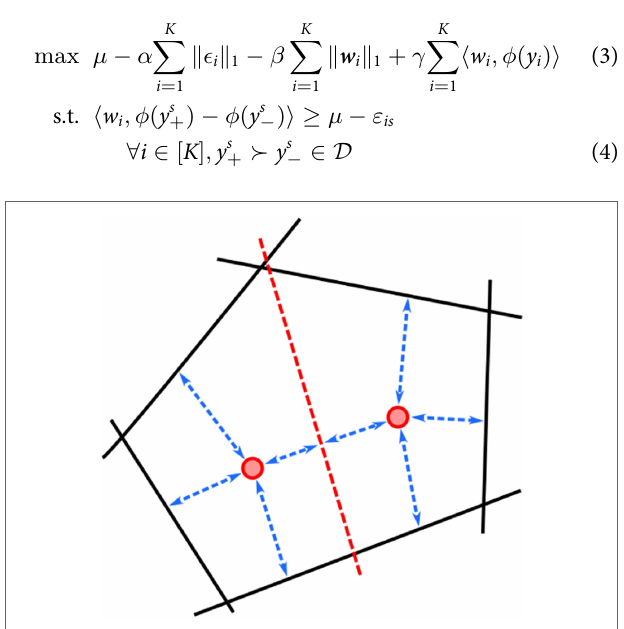
FIGURE 1 | Setwise max-margin optimization. The red points are weight vectors w 1 and w 2 ; the black lines correspond to preference constraints D t , and the red line corresponds to the hyperplane ⟨ w ,ϕ ( y t 1 ) − ϕ ( y t 2 ) ⟩ = 0. The arrows represent the separation